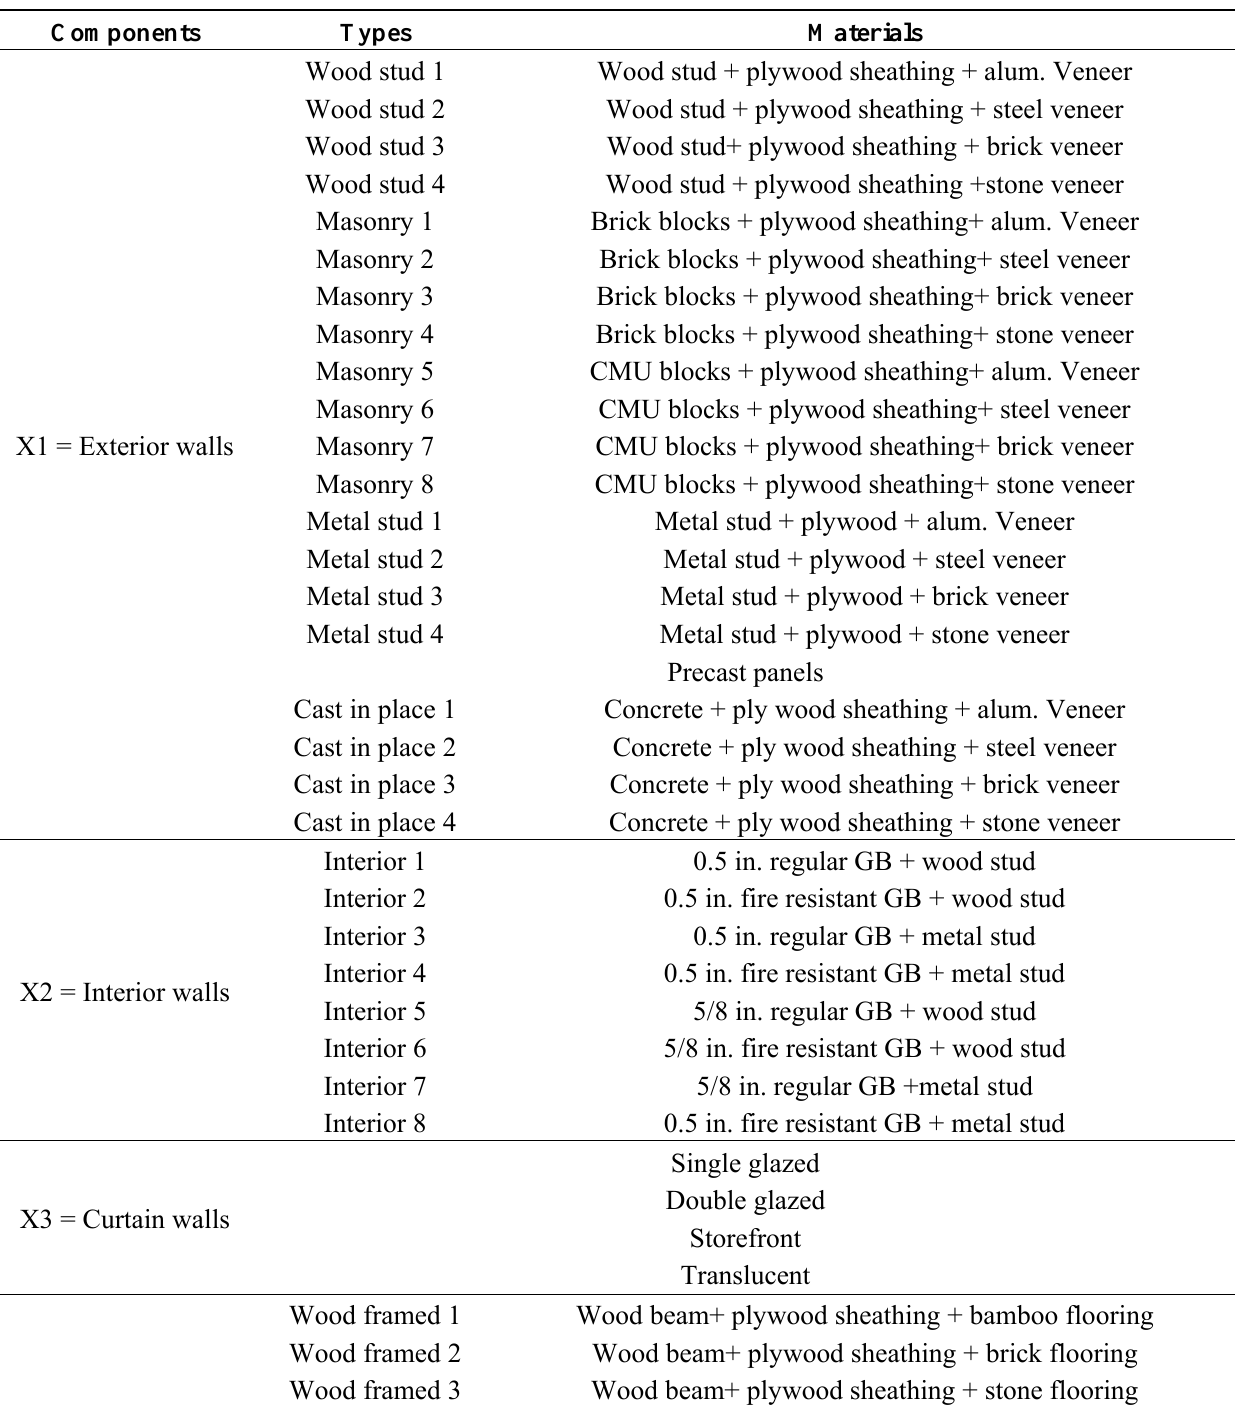
Table 5. List of Components, Types and